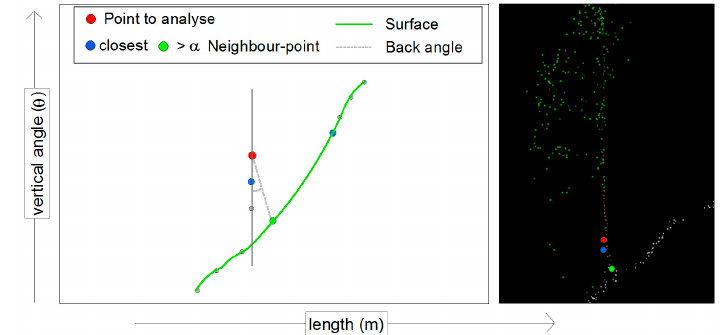
Figure 4. 2.5D reduction with max. angle below threshold line.